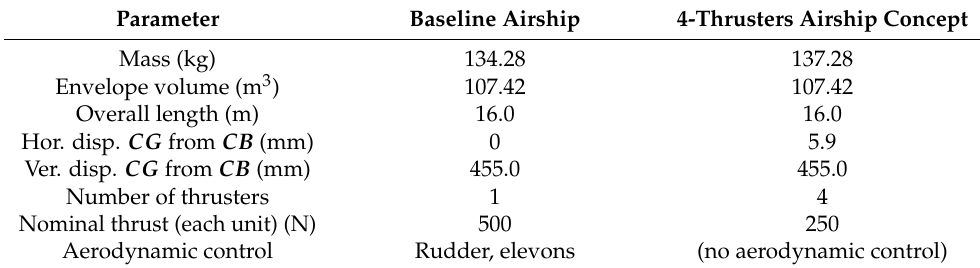
Table 1. Reference data for the considered airship test beds. Parameter Baseline Airship 4-Thrusters Airship